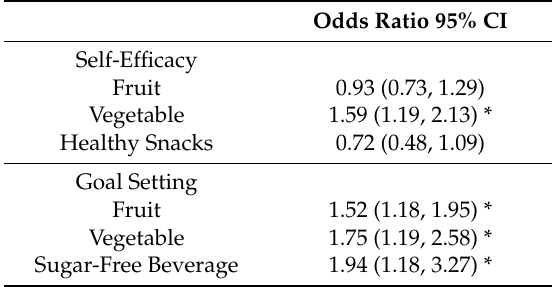
Table 3. Intervention effect on constructs embedded within the text